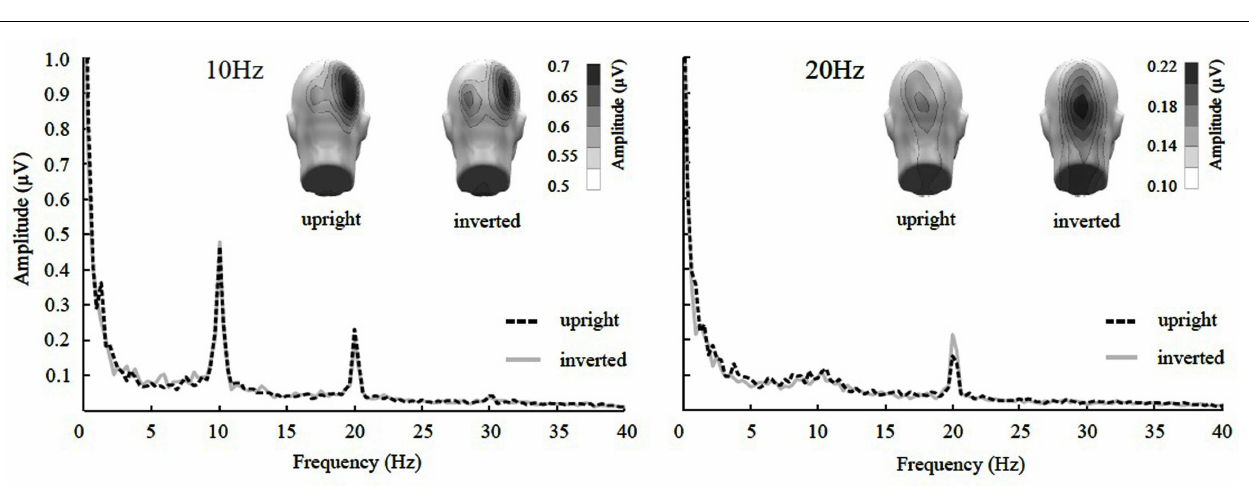
FIGURE 4 | Frequency spectrum at Oz together with topographical maps of evoked power at the stimulus frequencies of Experiment 2. SsVEP amplitude increase to inversion is significant for the 20Hz, but not for the 10Hz condition nor its 20Hz harmonic.